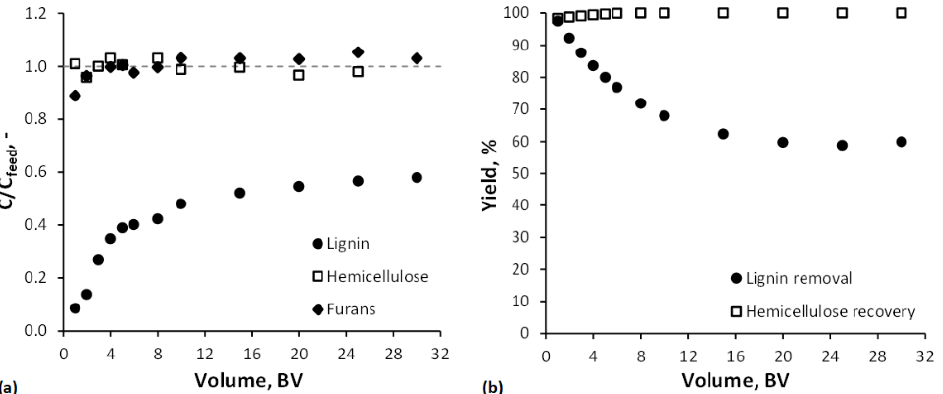
Figure 5. ( a ) Breakthrough curves of lignin, hemicellulose (oligomeric hemicellulose + monomeric xylose), and furans (5 ‐ HMF + furfural) and ( b ) lignin removal and hemicellulose recovery as a func ‐ tion of the bed volumes fed through the SP700 adsorbent bed with 4.5 BV/h.